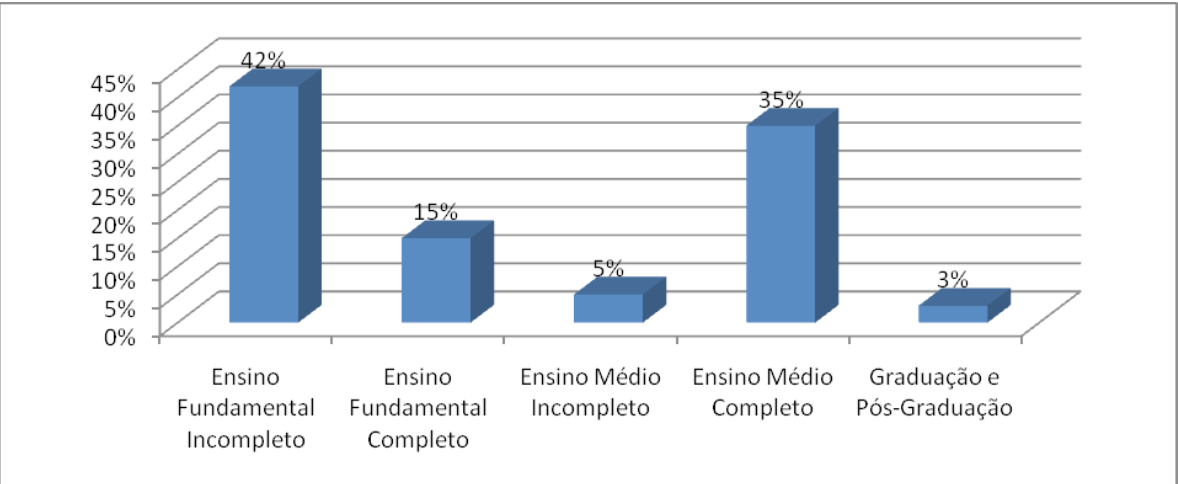
Figura 1. Nível de